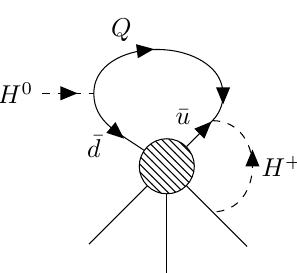
Figure 7. For some operators containing ¯ d ¯ u † the operator closure involves a motif like that shown in the figure. There is always an additional diagram with the roles of the unphysical Higgs and H 0 interchanged. Both diagrams are proportional to y u y d but related by a negative sign coming from the couplings of H + to up- and down-type quarks as shown in eq. (4.4), and therefore their sum